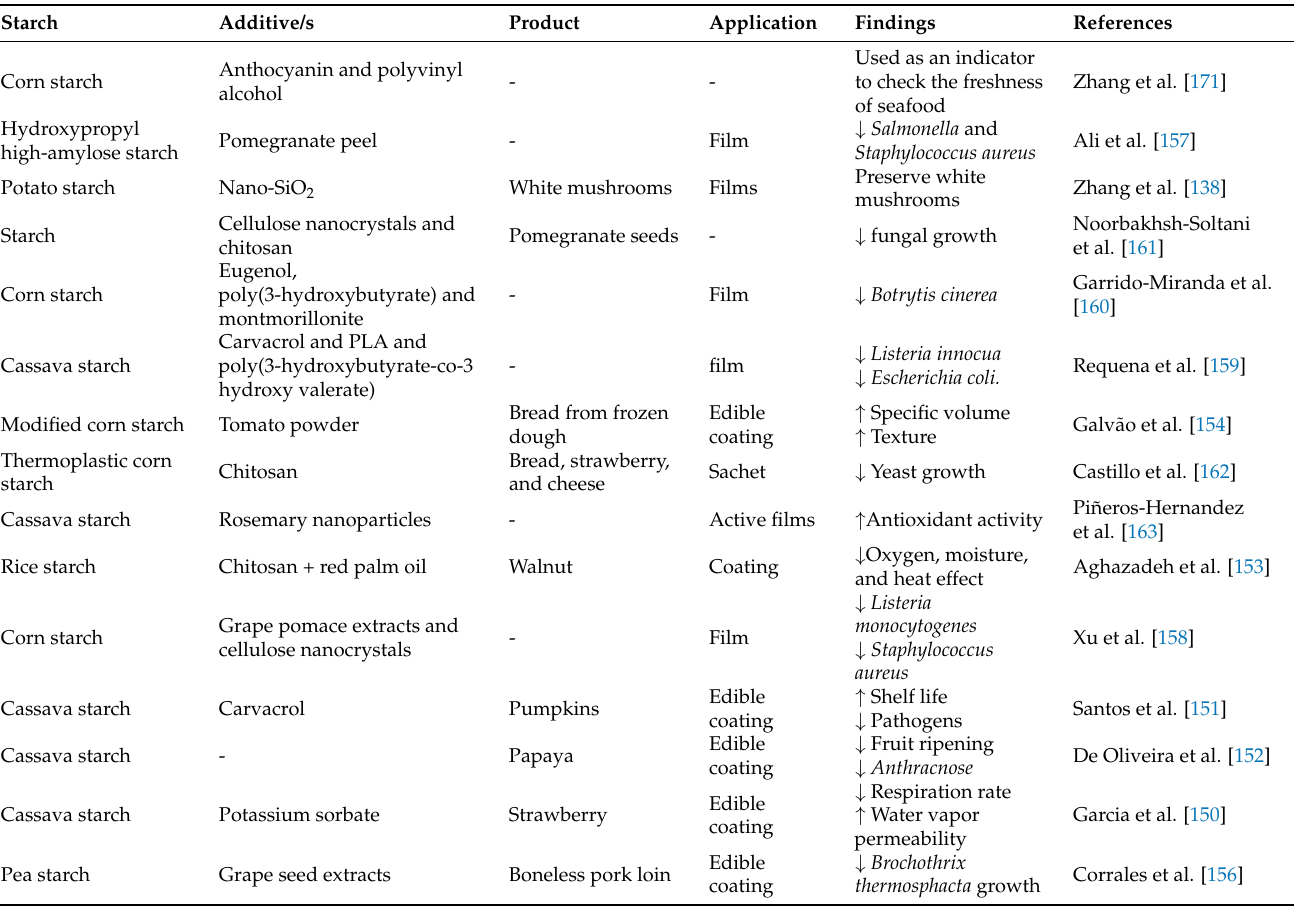
Table 4. Highlights of applications of starch-based films on food